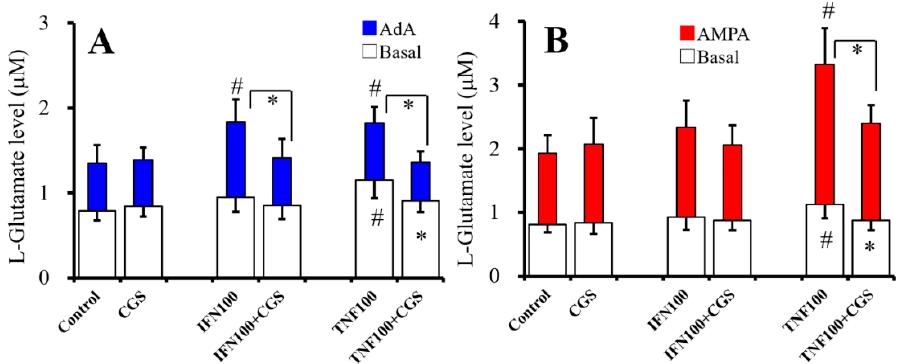
Figure 7. Interaction between chronic administration of cytokines and CGS21680 on basal, AdA-, and AMPA-evoked releases of L-glutamate. Interaction between e ff ects of chronic administration of IFN γ (100 IU / mL), TNF α (100 IU / mL), and CGS21680 (CGS: 10 nM) on basal (opened) and 1 µ M AdA-evoked ( A , blue) L-glutamate release are indicated in Figure 7A. Interaction between e ff ects of chronic administration of IFN γ (100 IU / mL), TNF α (100 IU / mL), and CGS21680 (10 nM) on basal (opened) and 100 µ M AMPA-evoked ( B , red) L-glutamate release are indicated in Figure 7B. Ordinates indicate mean levels of L-glutamate ( µ M) ( N = 6). * p < 0.05 relative to non-CGS and # p < 0.05 relative to control by two-way ANOVA with Tukey’s post hoc